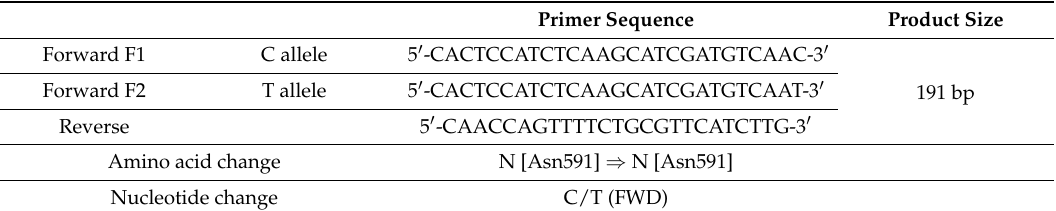
Table 1. Allele specific PCR primers for LDLR-rs688C/T gene